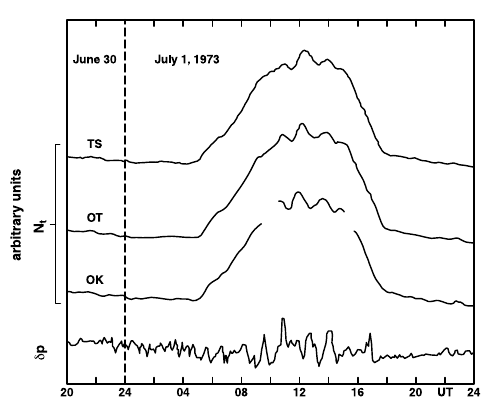
Fig. 13. Atmospheric ground pressure variation at Tsumeb (lower part), and Total Electron Content variation at Tsumeb (TS), Outjo (OT), and Okanhandja (OK) (upper part) on July 1, 1973 (Schoedel et al. , 1973) .